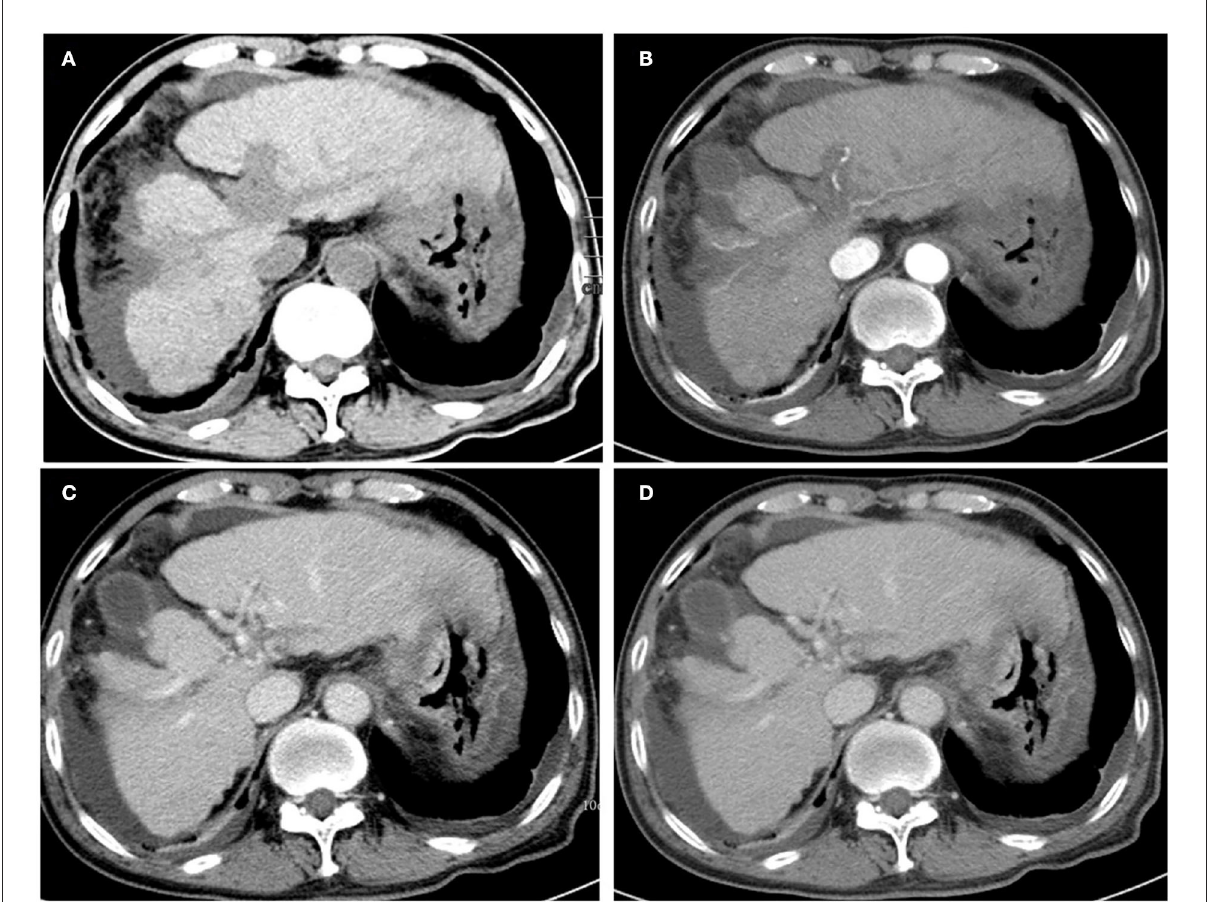
FIGURE3 Unenhanced (A) and contrast-enhanced abdominal CT images were obtained 20 weeks after the initial presentation. The mass on the left liver lobe disappeared, and the portal vein-filling defect was markedly reduced after post-therapy imaging. (B) The axial arterial phase. (C) The axial portal venous phase, and (D) the delay phase. Note that the bilateral pleural effusion indicated significant